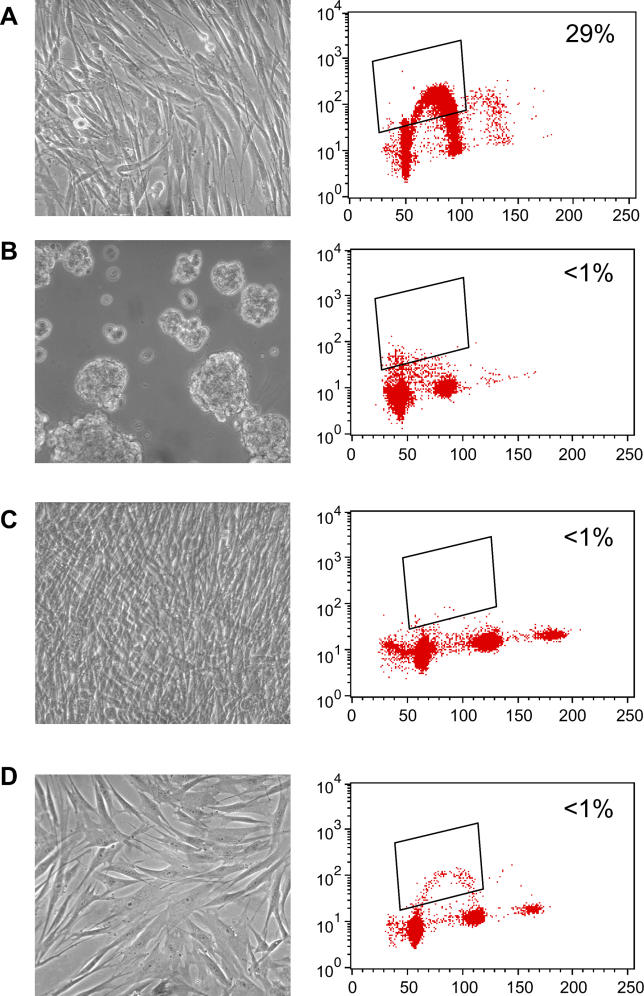
Model System: Growing and Arrested CellsPhotographs of growing cells (A), and cells arrested overnight by loss of adhesion (B), contact inhibition (C), or mitogen withdrawal (D) are shown. Growing cells and cells that were arrested for 4 d by one of the three different arrest signals were incubated with bromodeoxyuridine (BrdU). Cell nuclei were labeled with an anti-BrdU antibody and propidium iodide, and analyzed by FACS. DNA content was plotted along the x-axis, and BrdU intensity was plotted along the y-axis. In growing cells, 28% of the nuclei incorporated BrdU during a 6-h incubation, while less than 1% of the arrested cells incorporated BrdU during the same time period. At 14 h <10% of the cells were in S phase. 2N (G1) cells in all conditions were purified by sorting.